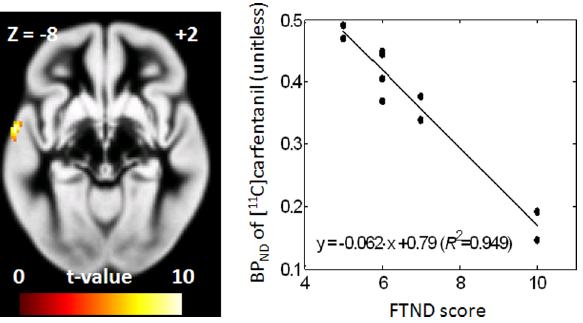
Fig. 3. Correlation clusters of [ 11 C]carfentanil binding potential (BP ND ) of placebo-cigarette scans versus the Fagerstro¨m Test for Nicotine Dependence (FTND) in smokers, displayed on trans-axial images of a gray-matter probability maps. Right panels show scatter plots using cluster [ 11 C]carfentanil BP ND , together with regression line. In regression equations, R 2 stands for the coefficient of determination.